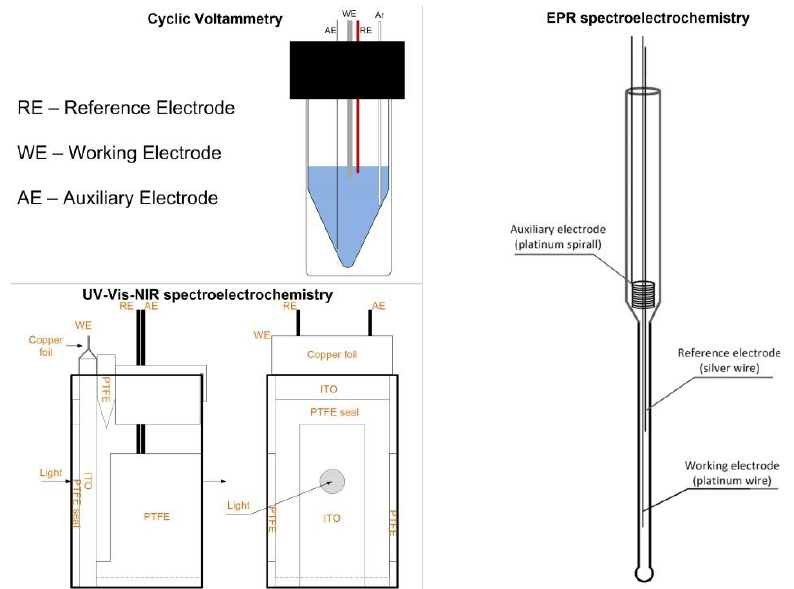
Figure 8. Electrochemical and spectroelectrochemical cells used for measurements. The figure presents the scheme setup of electrochemical/spectroelectrochemical cells using cyclic voltammetry, ultraviolet–visible and near-infrared (UV–Vis–NIR) and electron paramagnetic resonance (EPR) spectroelectrochemical measurements. This is adapted from Pluczyk, S., Vasylieva, M., Data, P. Using Cyclic Voltammetry, UV-Vis-NIR, and EPR Spectroelectrochemistry to Analyze Organic Compounds. J. Vis. Exp. (140), e56656, doi:10.3791/56656(2018)